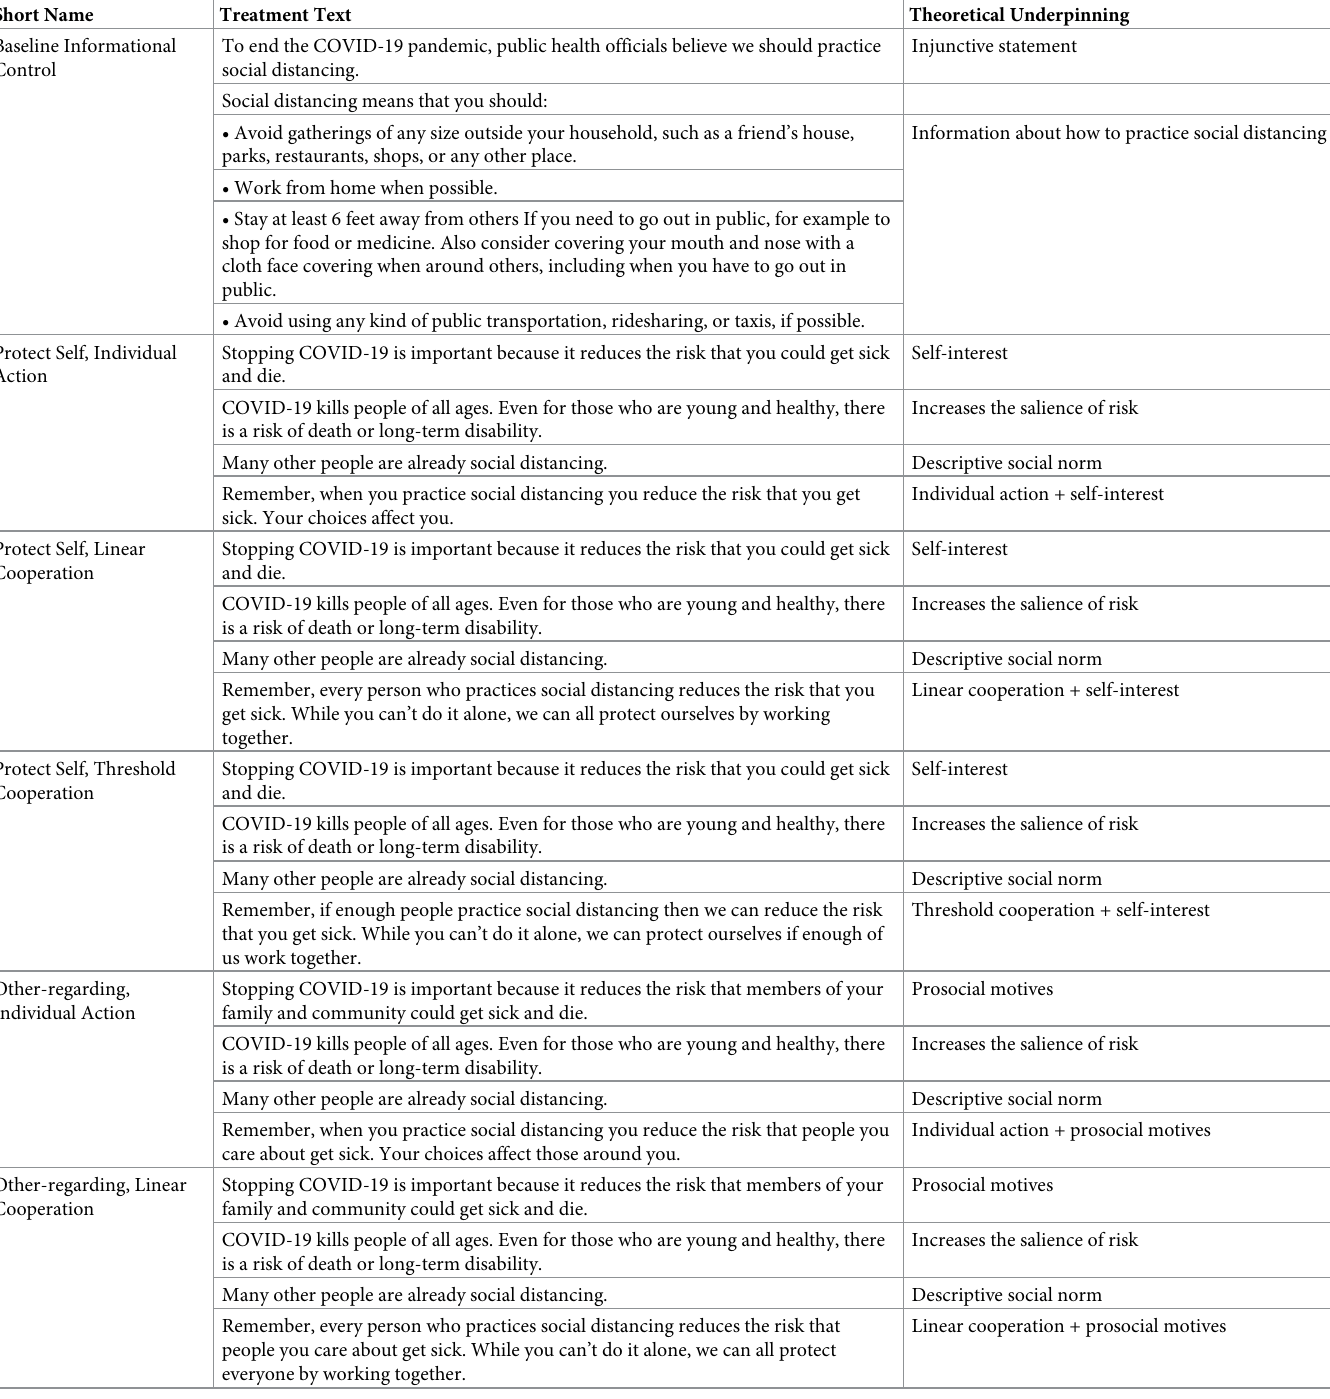
Table 1. Experiment 1 treatment messages and theoretical